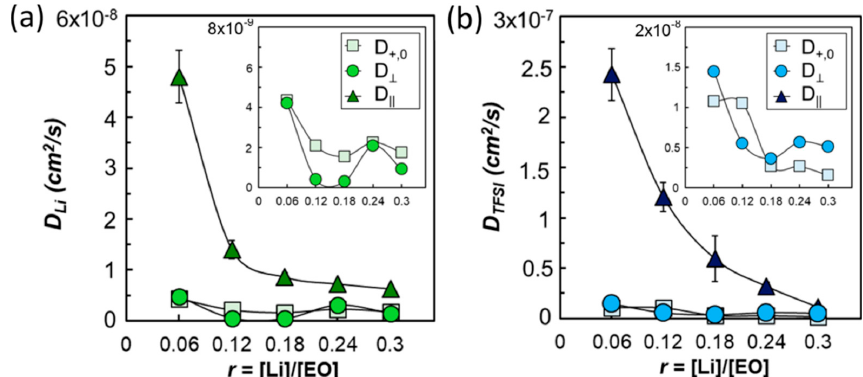
Figure 7. Parallel, D ‖ , and perpendicular, D ⊥ , di ff usion coe ffi cients and the Stefan − Maxwell diffusivities of ( a ) Li and ( b ) TFSI in SEO(16 − 16) as a function of salt concentration, r , at 90 °C [65]. Reprinted with permission from [65]. Copyright 2018 American Chemical Society.